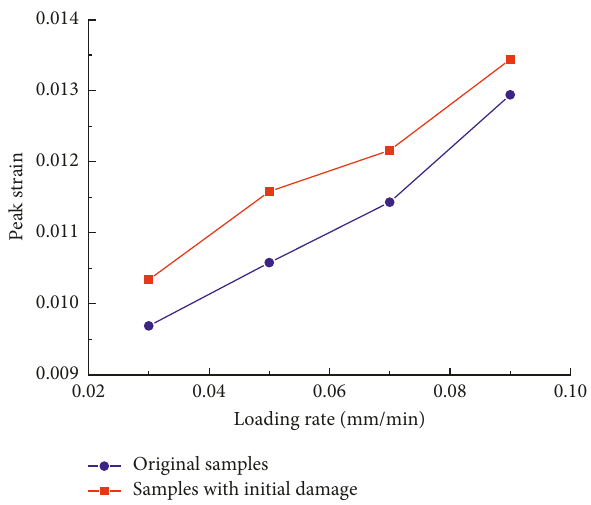
Figure 8: Relationship between the peak strain and loading rate.